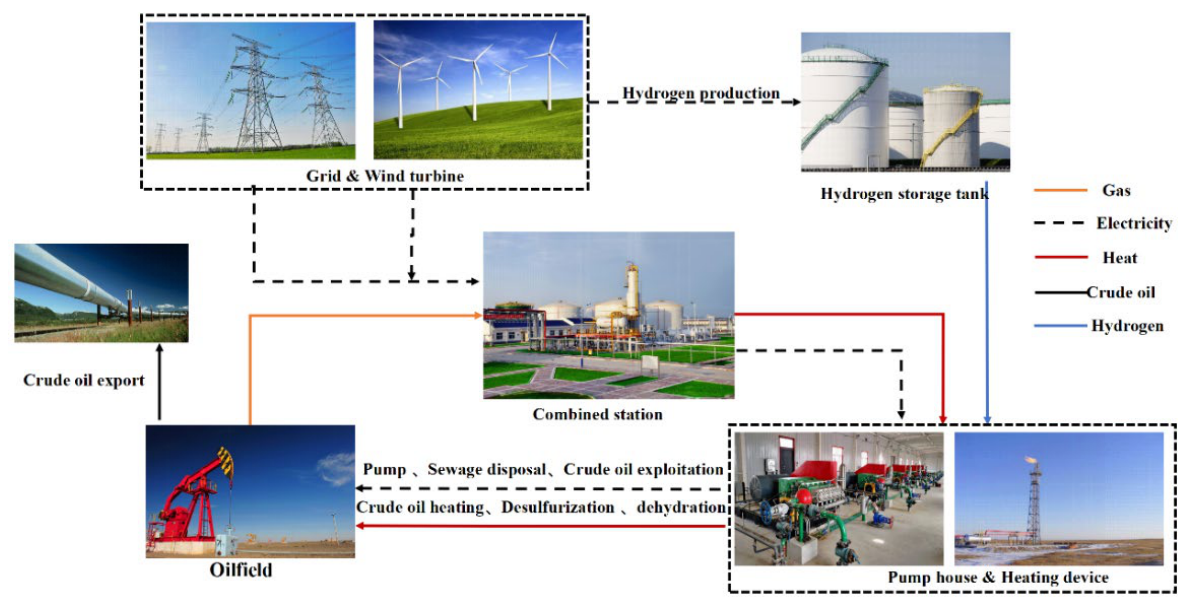
Figure 1. Oilfield hybrid energy system.